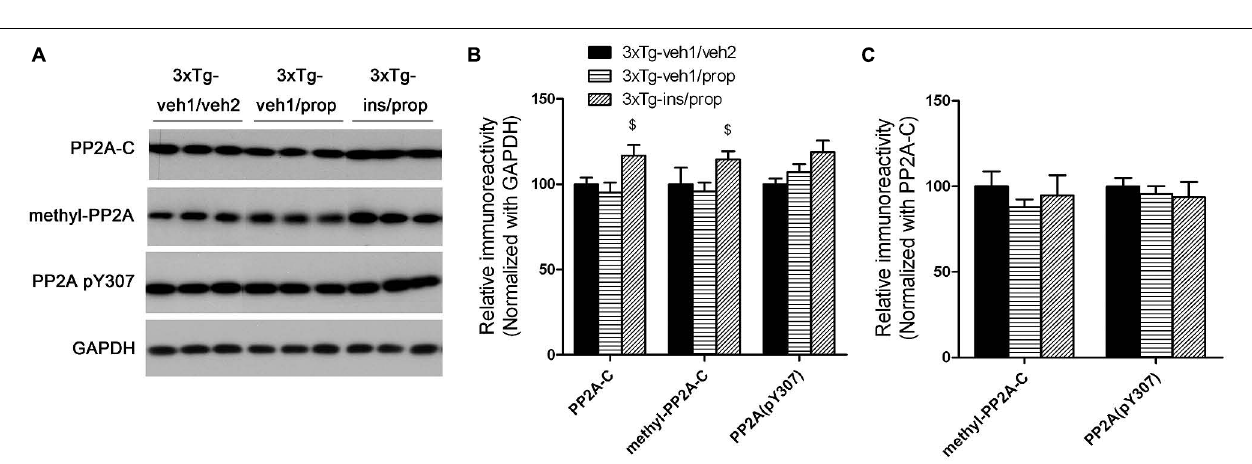
FIGURE 5 | Effect of propofol and intranasal insulin treatment on brain insulin signaling. Homogenates of the rostral halves of brains from mice sacrificed 30 min following propofol injection were analyzed byWestern blots developed with the indicated antibodies.The blots were then quantified